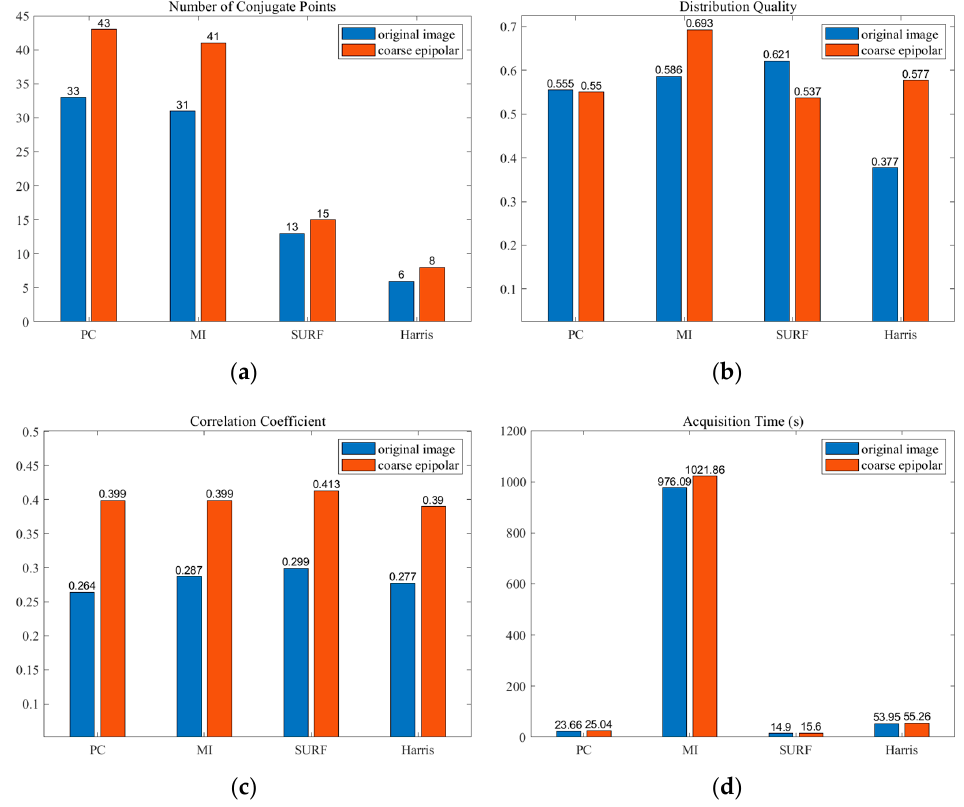
Figure 10. Matching results of Kompsat-3 along-track stereo images (template size: 500 × 500 pixels): ( a ) number of extracted conjugate points, ( b ) distribution quality, ( c ) correlation coefficient, and ( d ) acquisition time.